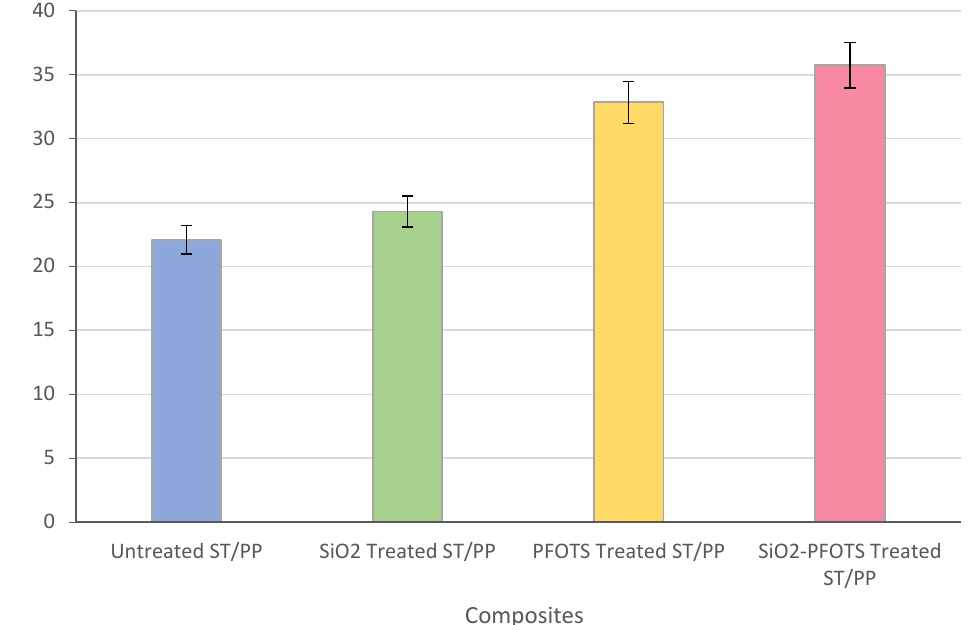
Figure 11. Flexural strength of untreated ST/PP, SiO 2 treated ST/PP, PFOTS treated ST/PP, and SiO 2 -PFOTS treated ST/PP.